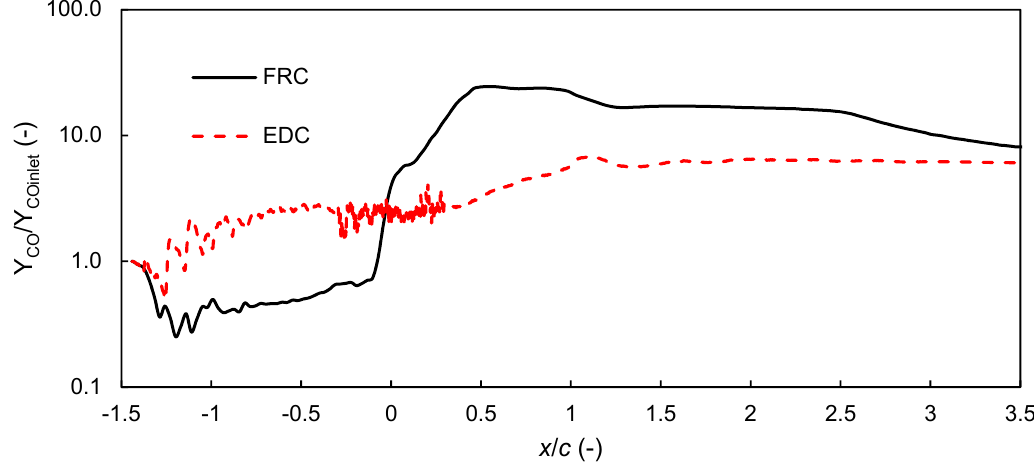
Figure 14. CO mass fractions for take-off conditions (A and B) calculated utilising the CFD model with the EDC, and the CRN model.